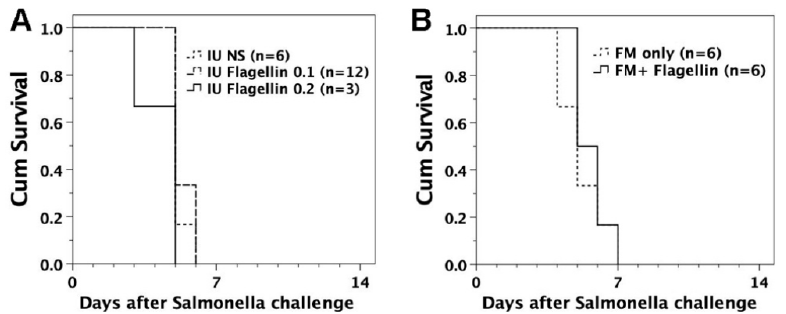
Figure 3. Intraperitoneal S. Typhimurium challenge. Six to eight weeks after the treatment of in utero flagellin injection or adoptive transfer of flagellin-loaded FMs, the recipient mice were subjected to intraperitoneal challenge of 10 5 live S. Typhimurium SL1344. ( A ) Mice with in utero flagellin injection (IU Flagellin 0.1 and 0.2) did not differ in survival ( p = 0.470 and 0.152) from those with saline injection (IU NS). ( B ) There was no significant difference in survival ( p = 0.511) between adult recipients with injection of flagellin-loaded FMs (FM + Flagellin) and FMs without flagellin loading (FM